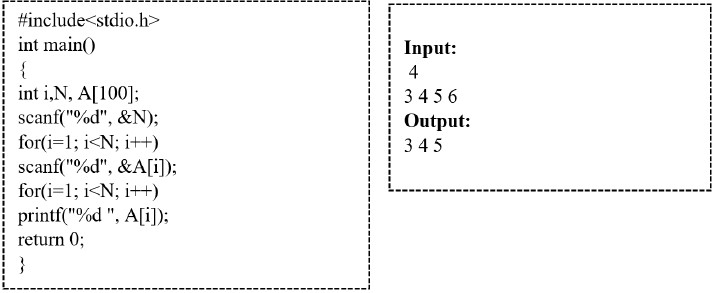
Figure 8. Example of source code with logic error and its input and output.